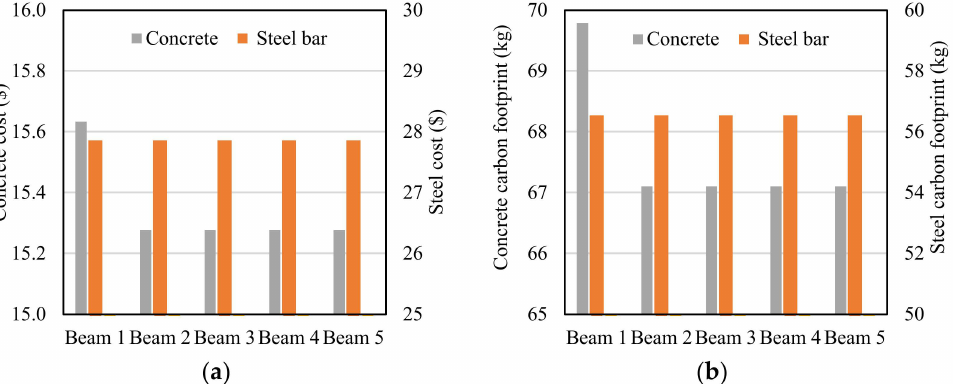
Figure 14. Results of the cost and carbon footprint of the reinforced concrete beams: ( a ) cost and ( b ) carbon